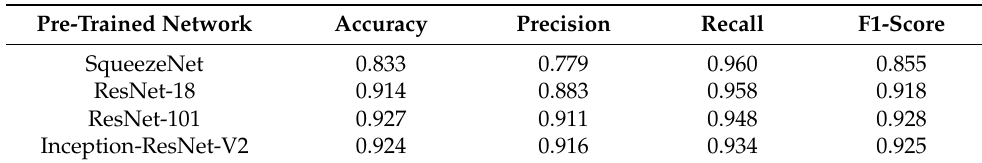
Table 3. Performances of deep-learning models on dataset 1.